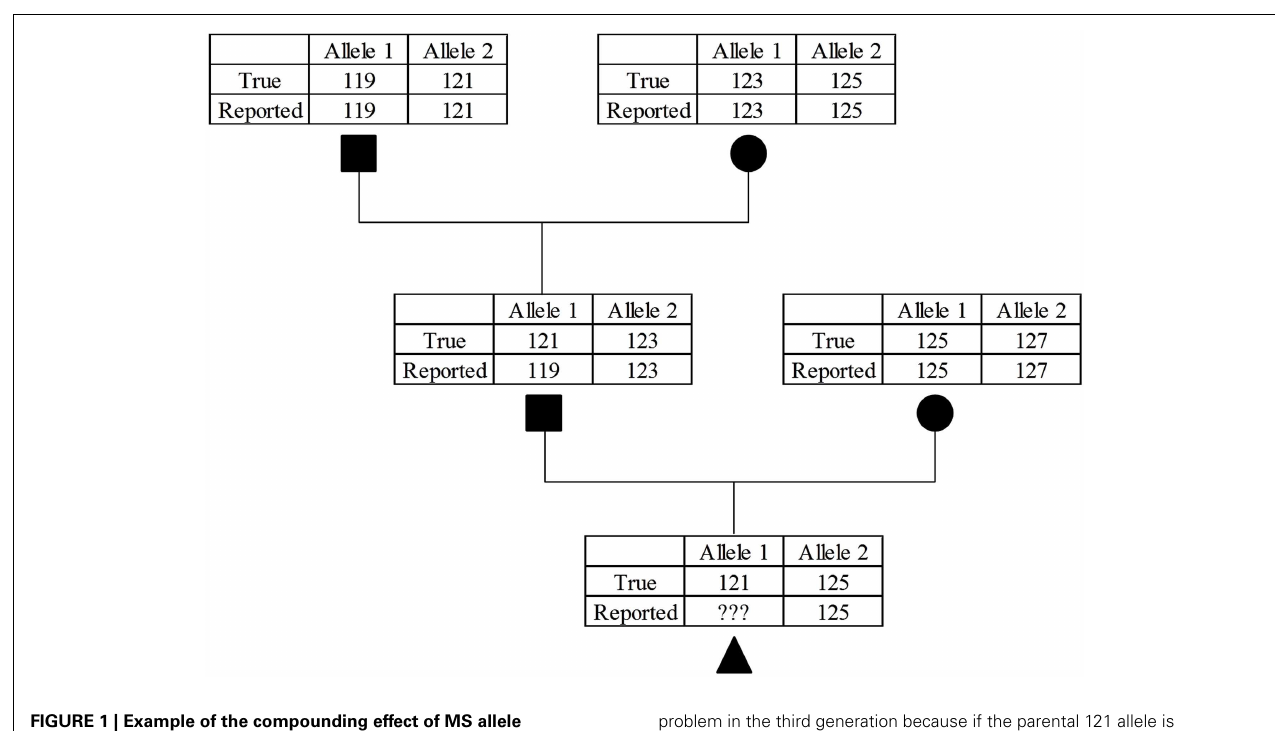
FIGURE 1 | Example of the compounding effect of MS allele miscalls. While the sire in the second generation was misgenotyped for the parental allele it was not caught because the error still follows Mendelian inheritance patterns.This will cause a